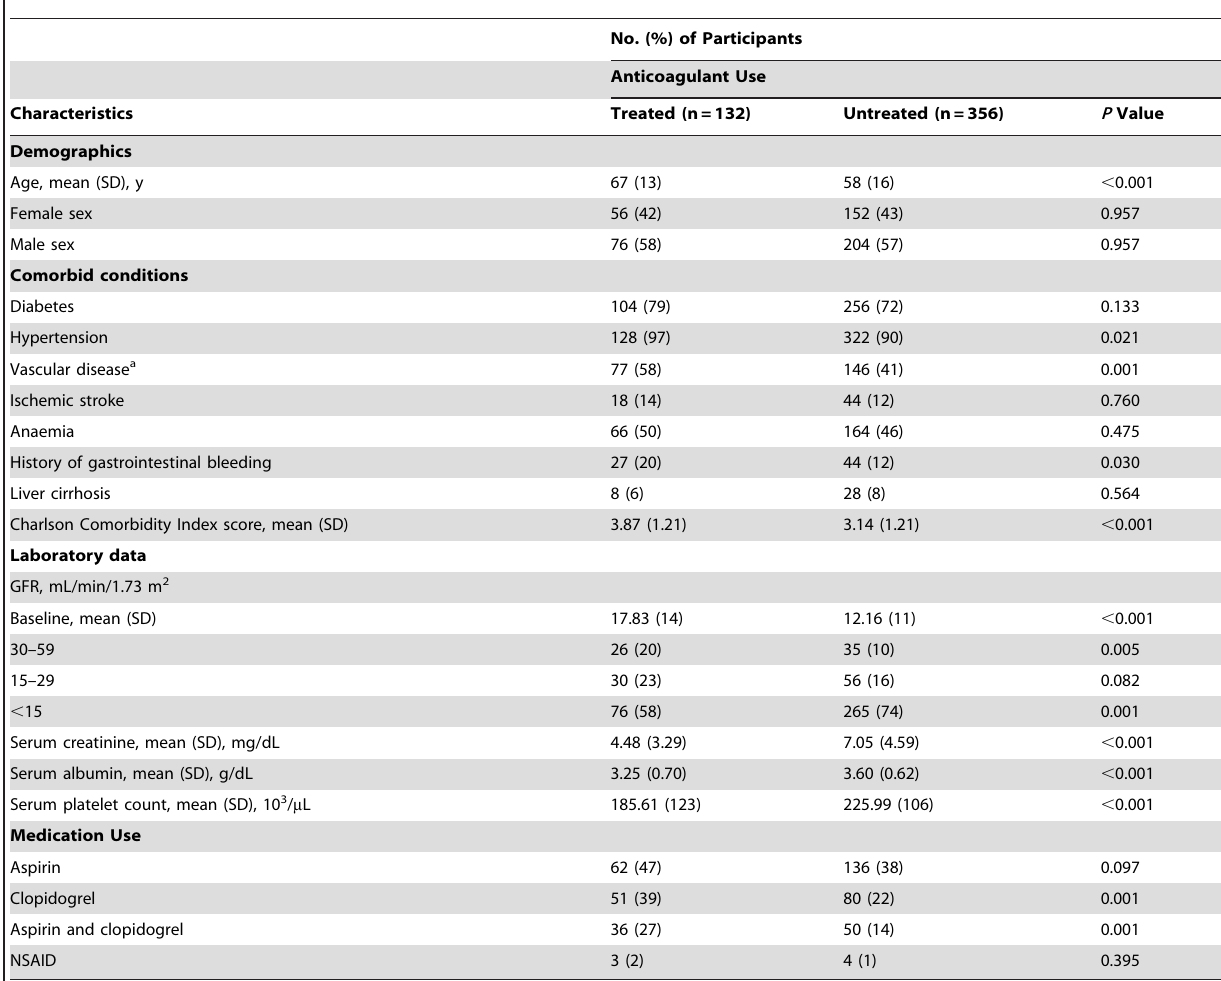
Table 1. Baseline characteristics of patients with and without anticoagulant use.